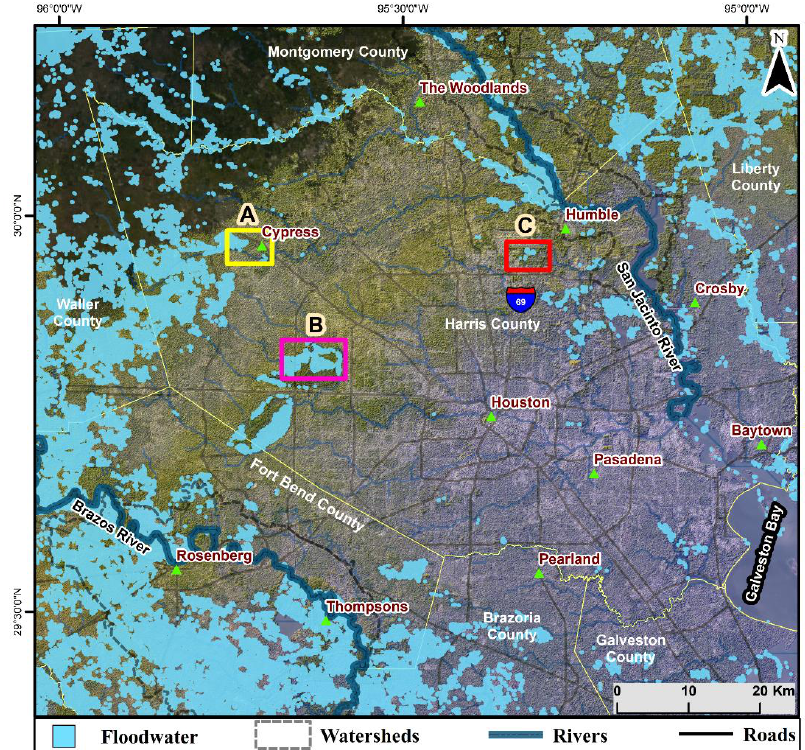
Figure 3. CCD-based map of the recurrently flood-affected areas of Houston and its surrounding areas, generated using Sentinel-1 data acquired before and after the flooding events following the Tax Day storm (2016) and Hurricane Harvey (2017). Three sites (A, B, and C shown in yellow, pink, and red, respectively) were randomly selected to demonstrate the changes in the coherence of pixels, thereby signifying flooding.